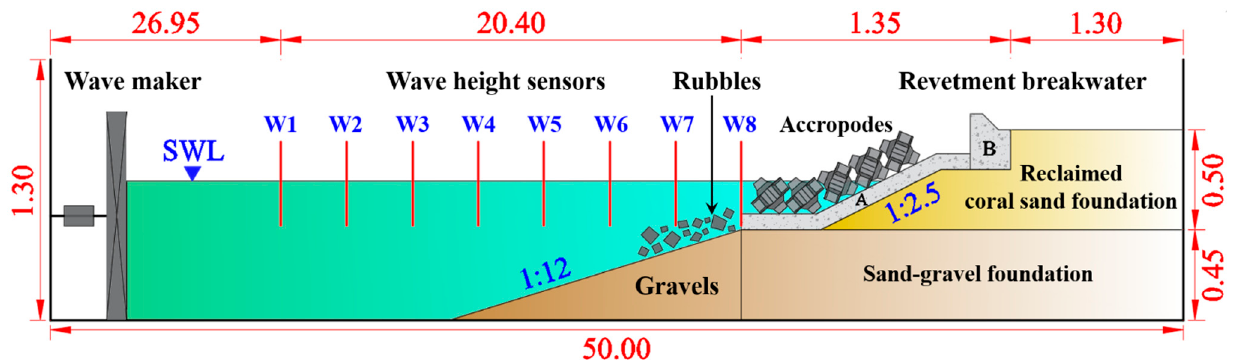
Figure 1. Schematic map of the physical model constructed in the wave flume (unit: m) (the revetment is labelled as A, and the vertical caisson is labelled as B).